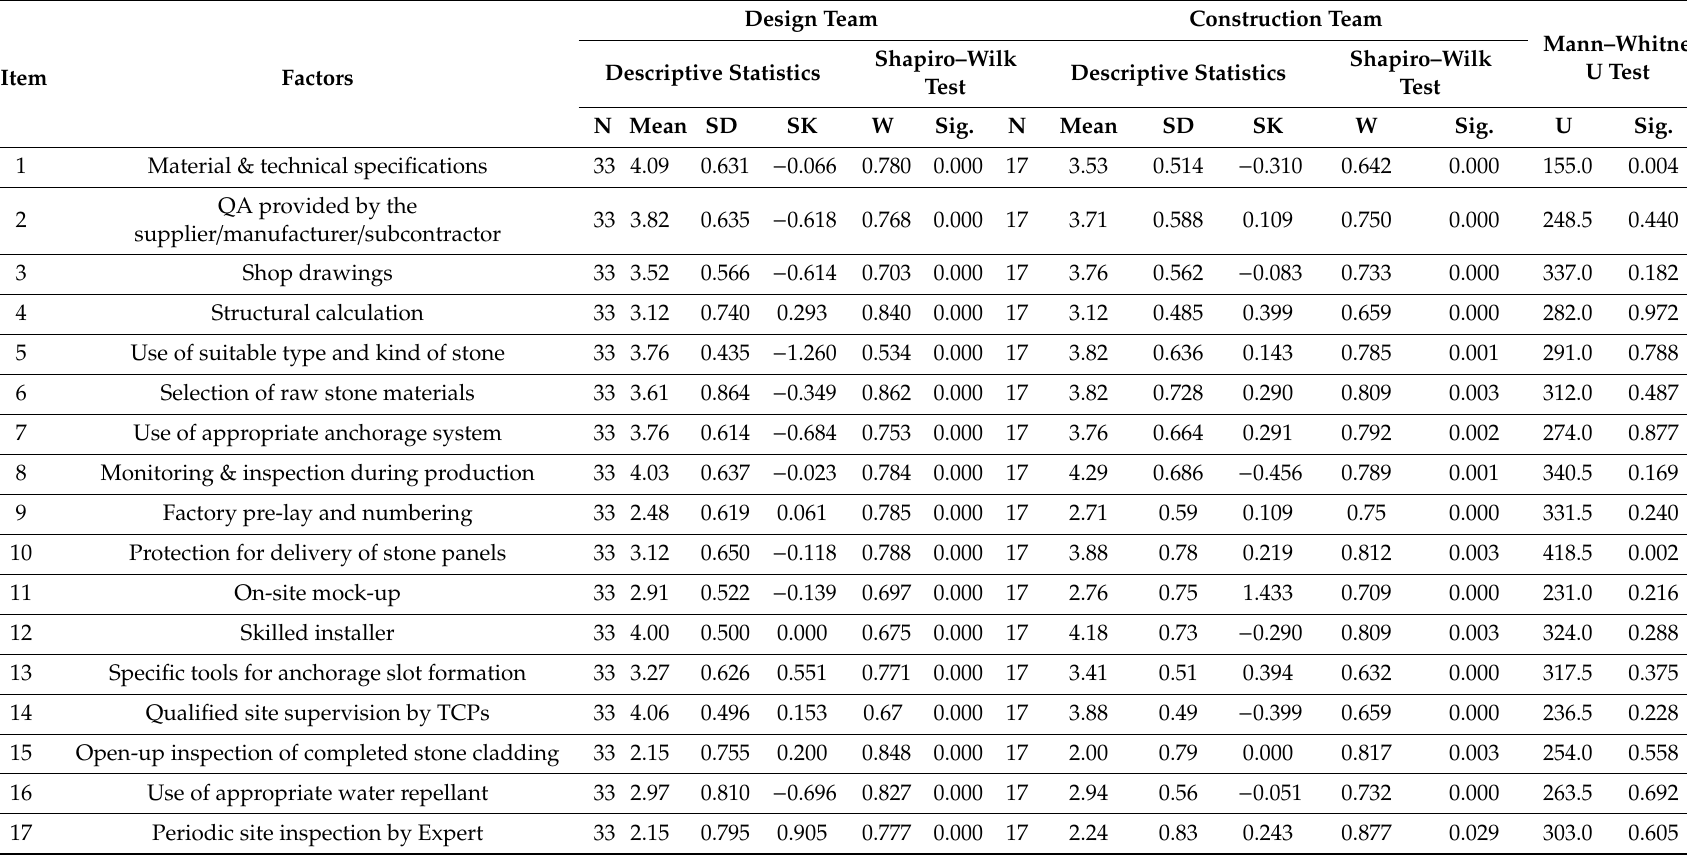
Table 4. Factors to ensure the quality in the installation stage (Comparison between ‘Design Team’ and ‘Construction Team’, n =